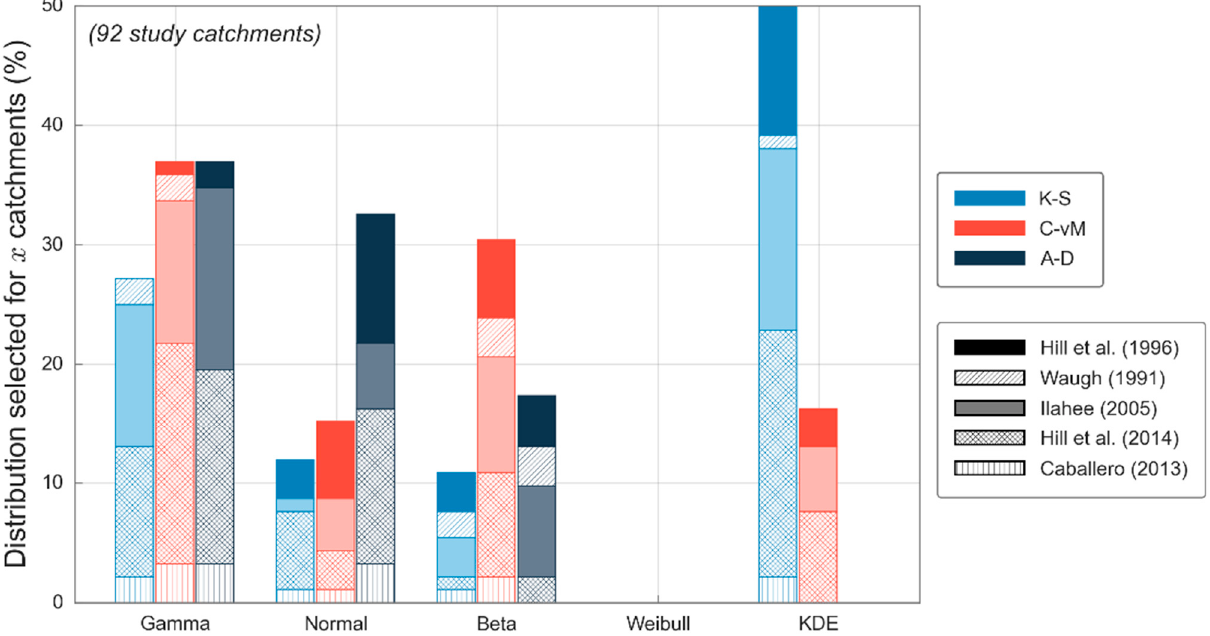
Figure 3. Percentage of catchments (with sample size greater than 10) in which each candidate distribution is selected by each goodness-of-fit test, for each study dataset.